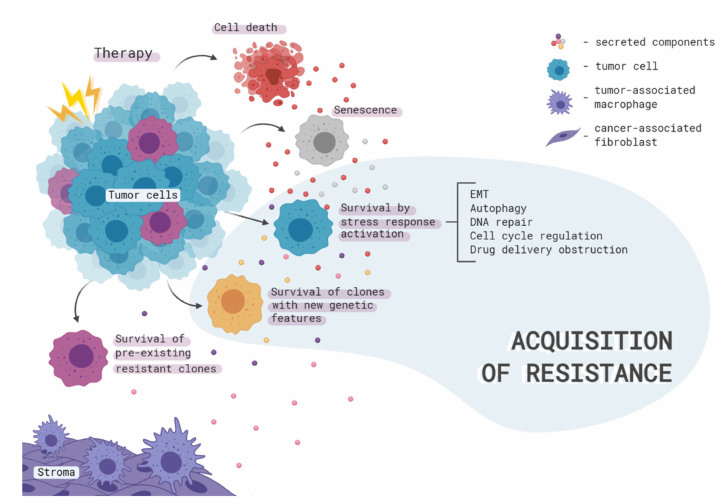
Figure1. Acquisitionofcancercellresistancefromthepopulationpointofview. Thetumoris heterogeneous and consists of both therapy-sensitive and resistant cancer cells. Also, tumor-associated immune and stromal cells surround the tumor, creating a unique tumor microenvironment. Therapy simultaneously triggers many events: cell death, the transition to a state of senescence, the survival of pre-existing resistant clones, and the acquisition of new genetic and epigenetic features by cells, as well as activation of stress response cascades therein. All these processes lead not only to a change in the cellular composition of the tumor and tumor stroma but also to the transformation of the secretion profiles of all participants in intercellular communication. Such communication enhances the e ffi ciency of the cellular response to stress, which, together with genomic instability and clonal selection, ensures the adaptation of cells to therapy, expansion of the most resistant tumor populations, and tumor recurrence.